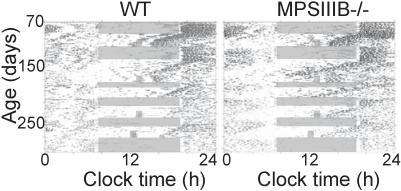
Locomotor activity records of a representative wild-type and MPS IIIB mouse.Running wheel revolutions per minute (black bars) is plotted for 24 h on each line with subsequent days plotted on the line below. In a light:dark schedule (gray bars show when lights were on), the mutant mice adjusted rhythm to light similar to wild type mice. The mice experienced a series of light:dark, dark:dark, and skeleton photoperiod schedules from ages 70–275 days.